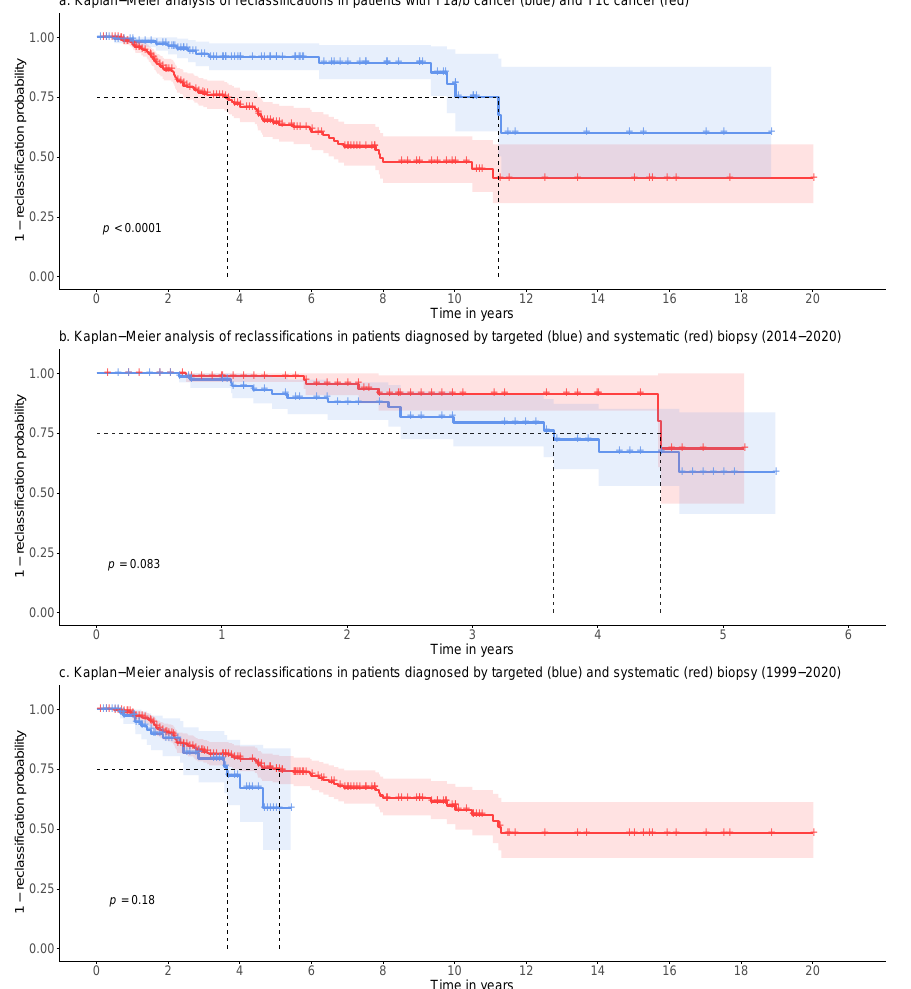
Figure 3. ( a ): Kaplan–Meier analysis of reclassifications in patients with T1a/b cancer (blue) and T1c cancer (red): 25% of the patients are reclassified within 3.6y (T1c) and 11.2y (T1a/b). A total of 95% CI in light blue and light red, ( b ): Kaplan–Meier analysis of reclassifications in patients diagnosed by targeted (blue) and systematic (red) biopsy using the data from 2014–2020: 25% of the patients are reclassified within 3.6y (targeted) and 4.5y (systematic) ( c ): Kaplan–Meier analysis of